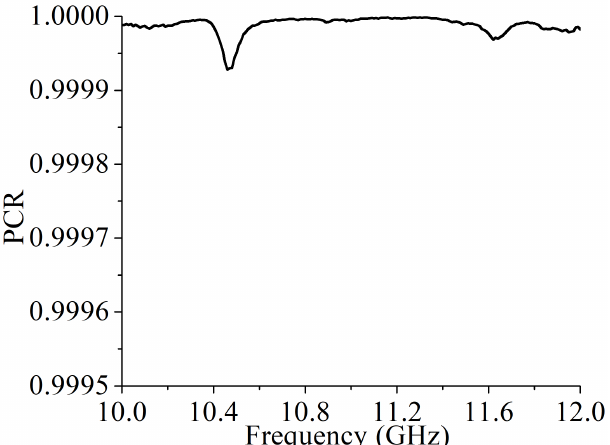
Figure 12. The polarization conversion ratio calculated from the measured